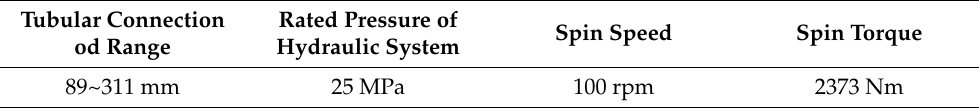
Table 1. Technical parameters of the spinner